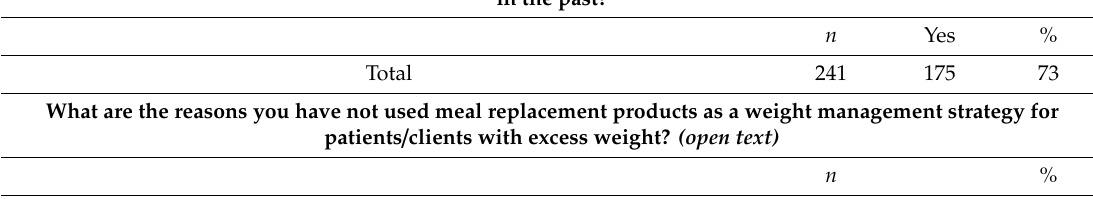
Table 2. Healthcare professionals’ experiences and uses of meal replacement products in daily